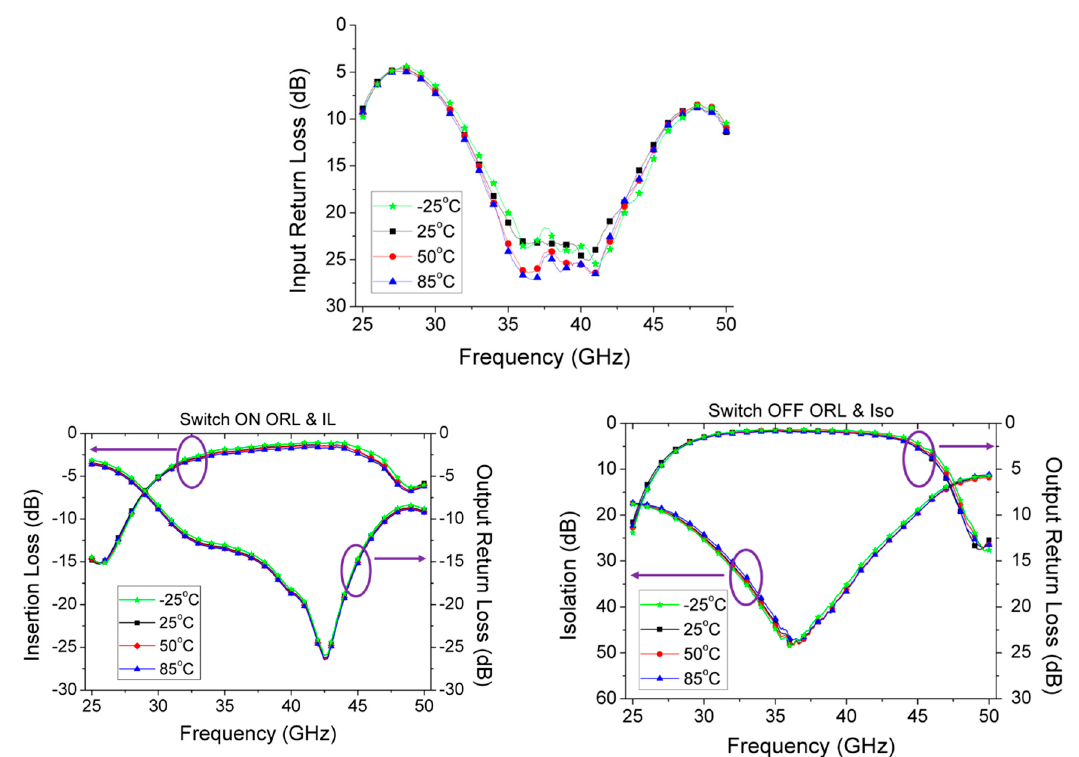
Figure 15. Measured small-signal performance of the fabricated chip with varying temperature.